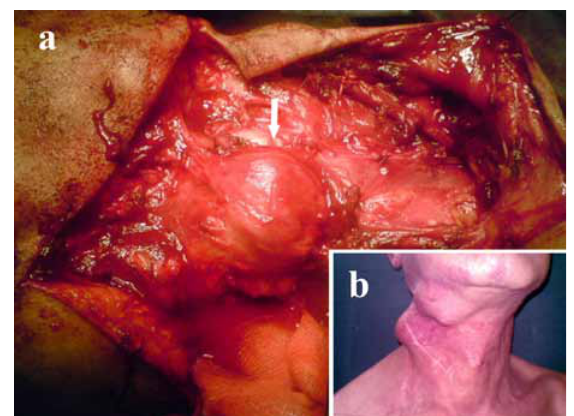
Figure 4. a: Intraoperative picture of the tumor; b: local recurrence with the shape of saddle bag before second